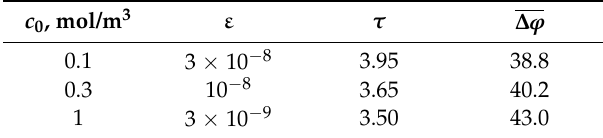
Table 2. The transition time and PD in the quasi-stationary